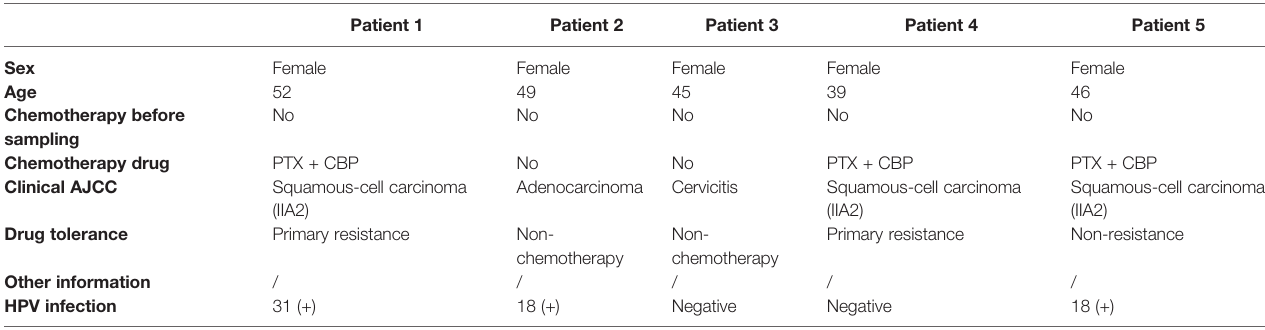
TABLE 1 | Clinical information of the fi ve